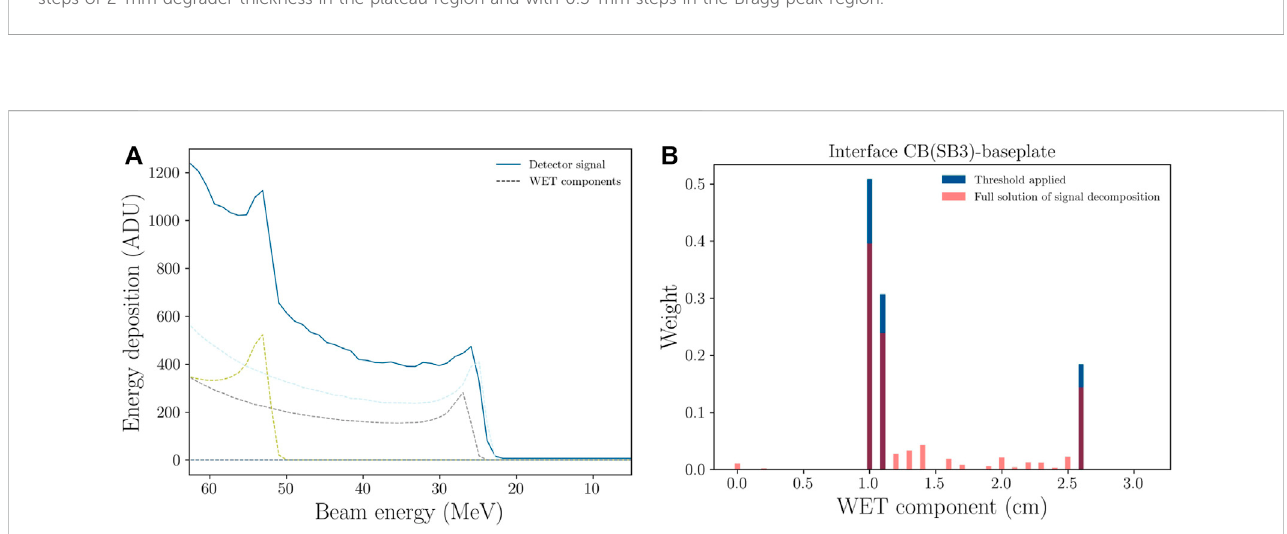
FIGURE 5 Lookuptablesfromcalibrationmeasurements (A) withPMMAplatesand (B) complementedbyFLUKAMCsimulations.Measurementswerecarriedoutin steps of 2-mm degrader thickness in the plateau region and with 0.5-mm steps in the Bragg peak region.